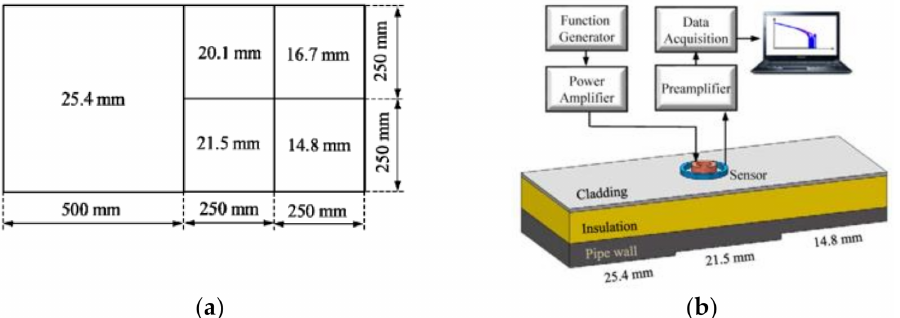
Figure 4. Experimental set-up for PECT: ( a ) The 16Mn steel step wedge plate. ( b ) experimental schematic diagram.